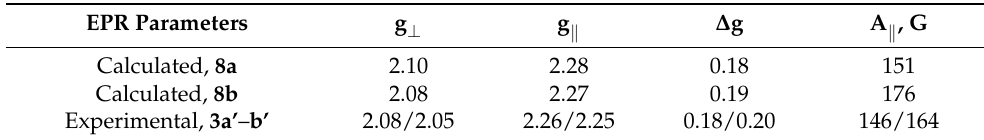
Figure 15. Top and side view of the optimized structures of the mononuclear green mycaminosyl complexes ( B3LYP )- 8a ( a , b ) and 8b ( c , d ), with structural parameters and NBO charges. Colour code: C—grey, O—red, N—blue, Cl—green, Cu—magenta. Table 7. Calculated EPR characteristics of the mononuclear green mycaminosyl complexes in solid state.